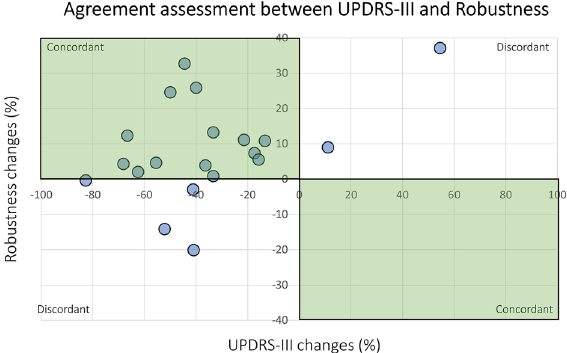
Figure 3. Agreement between UPDRS-III changes ( x -axis) and neuromuscular robustness changes ( y -axis). The relative changes at 12 months after DBS with respect to baseline are represented (T 2 –T 0 ). The quadrants showing concordance are highlighted in